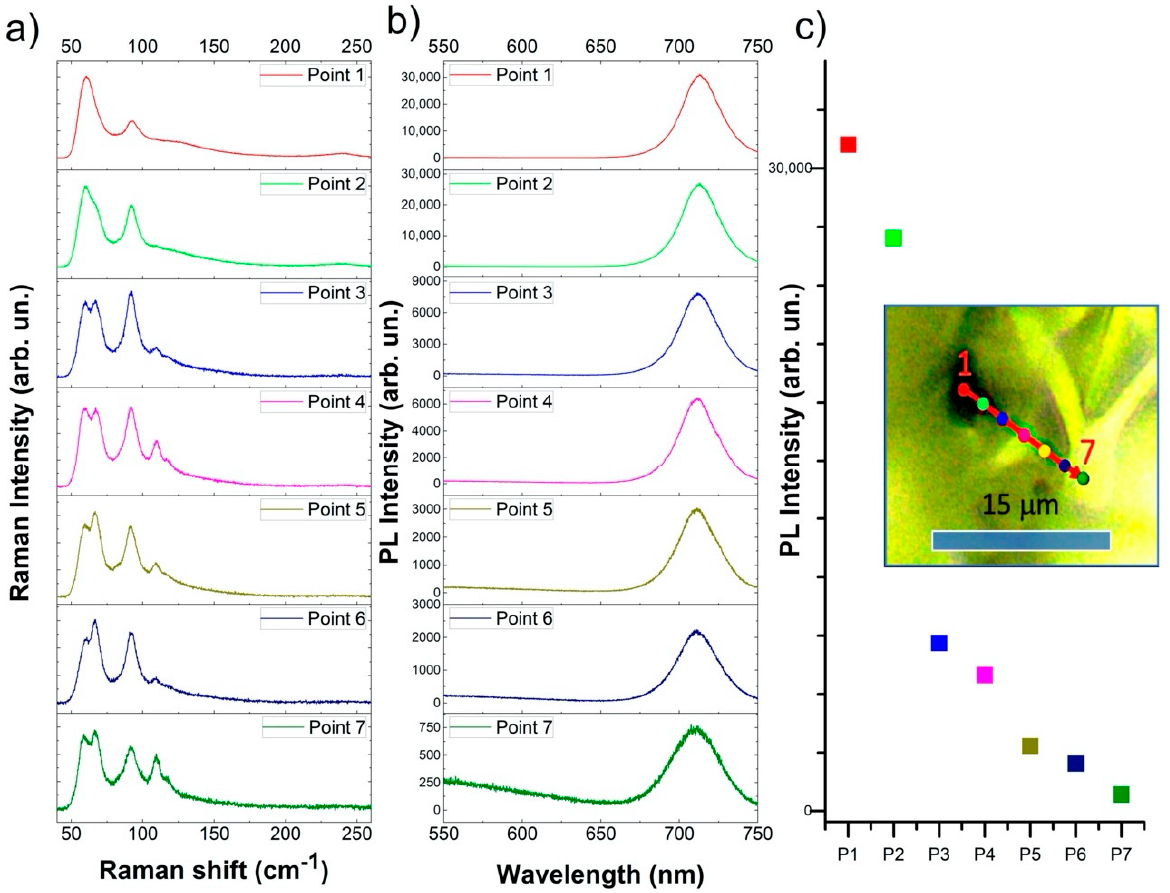
Figure 7. Raman and luminescence measurements on seven points in the CPI3-10 h sample. ( a ) Raman spectra, ( b ) lumi- nescence spectra and ( c ) 715 nm PL intensity. The spectra were collected at a spatial point indicated in the inset of panel ( c ). The colour relates the Raman and luminescence spectrum, the intensity of the peak at 715 nm and the point in the map.